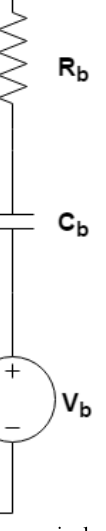
Figure 4. Battery equivalent circuit